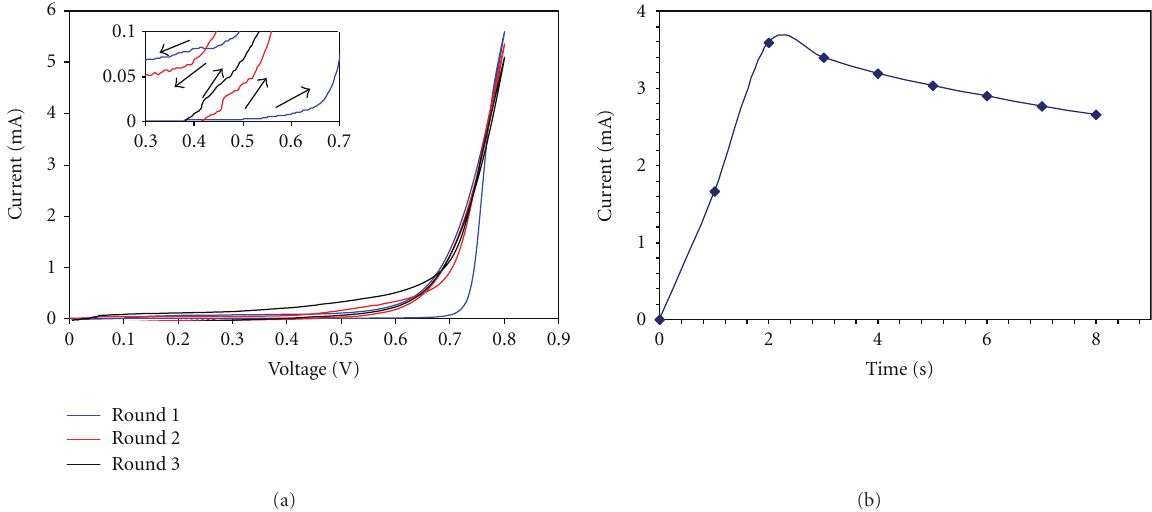
Figure 1: (a) Plot of deposited current versus voltage of alternate current (AC) deposition of the 3-round PPy film ( AC-3R-PPy ); arrows in the inset indicate the direction of deposition voltage. (b) Plot of the deposited current versus time of direct current (DC) of 8-s PPy films ( DC-8s-PPy ).